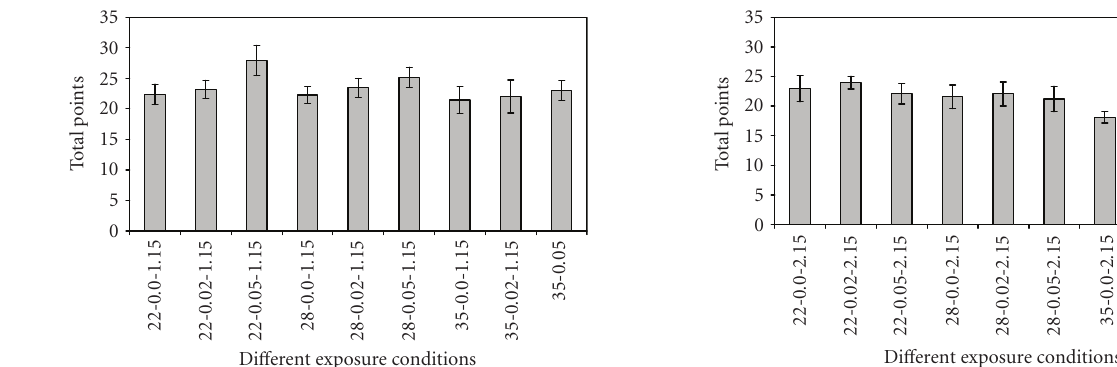
Figure 7: The average number of holes visible to all the observers under 9 di ff erent conditions with the 1 . 15cm phantom. In each condition (the horizontal axis), the first number represents the X- ray energy (kVp) and the second number represents the thickness (in mm) of the Mo filter. It shows that the X-ray image taken using 22 kVp and 0 . 05 mm Mo filter has the highest total points (27 . 73). The error bars indicate the standard errors for the means of the points under each condition.